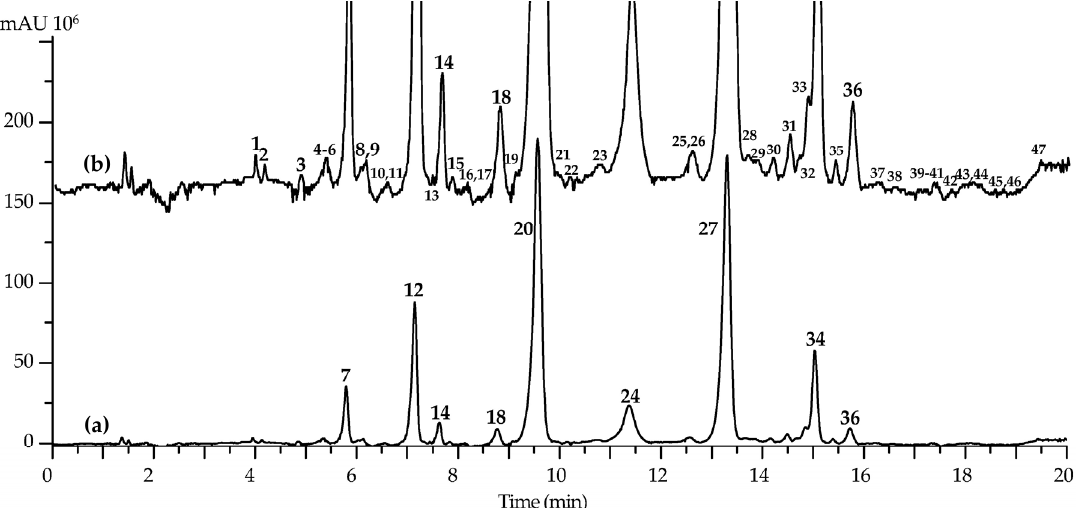
Figure 2. High-performance liquid chromatography data of Amberlite XAD-2 fraction of cucumber flowers with photodiode array detection (( a ); 330 nm) and electrospray ionization triple quadrupole mass spectrometric detection (( b ); negative detection, base peak chromatogram). Compounds are numbered as listed in Table 6.